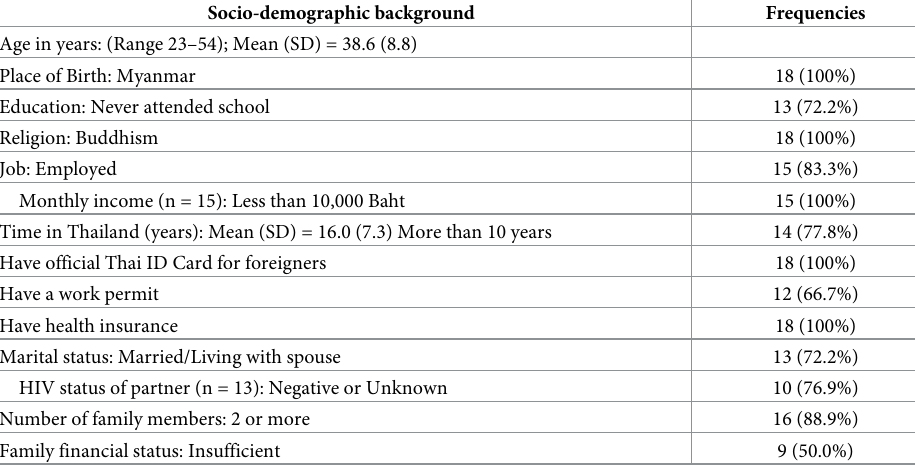
Table 1. Socio-demographic background of female Shan living with HIV (N = 18). Socio-demographic background